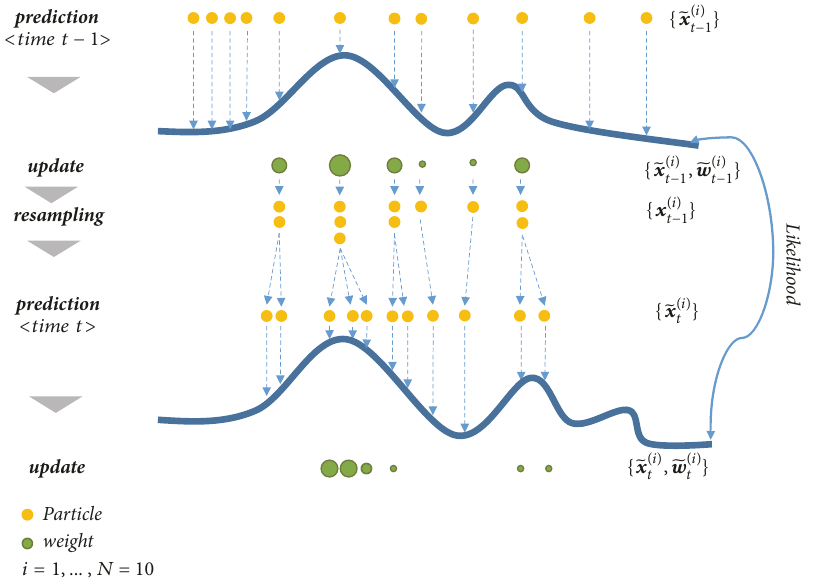
Figure 8: Importance sampling process for a particle